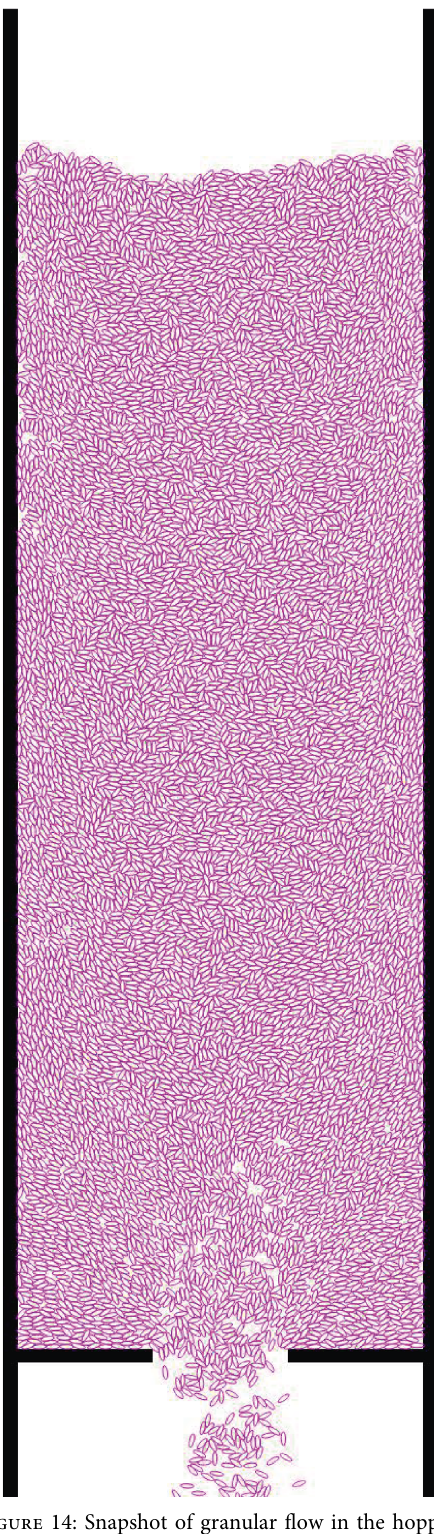
Figure 14: Snapshot of granular flow in the hopper.